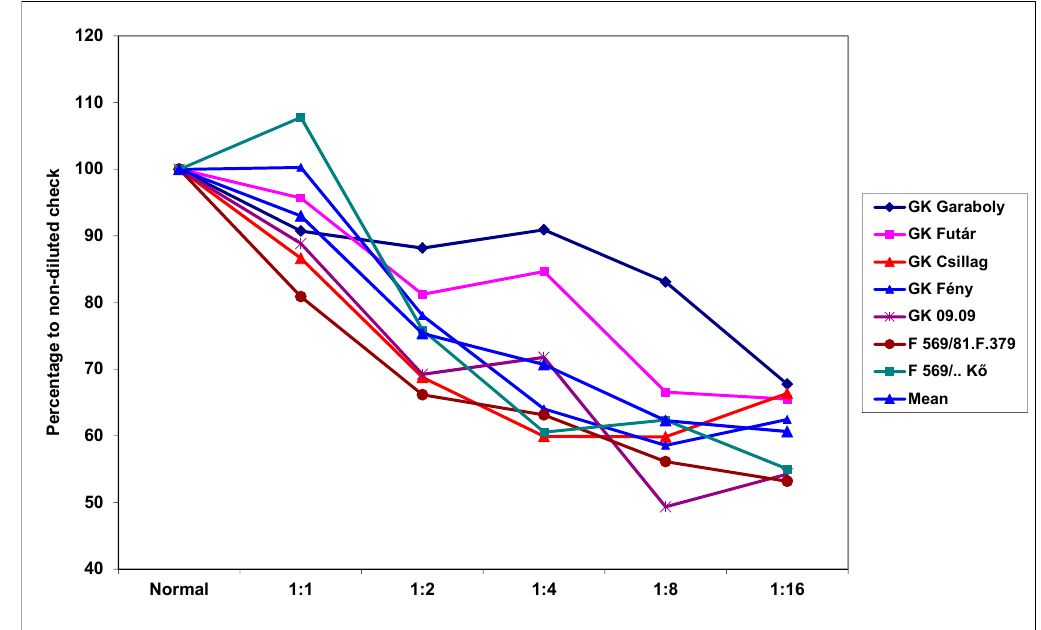
Figure 5. Reduction of the aggressiveness of F. graminearum and F. culmorum isolates at different dilution rates, FDK data, 100 = non-diluted inocula across isolates, 2013 and 2014.